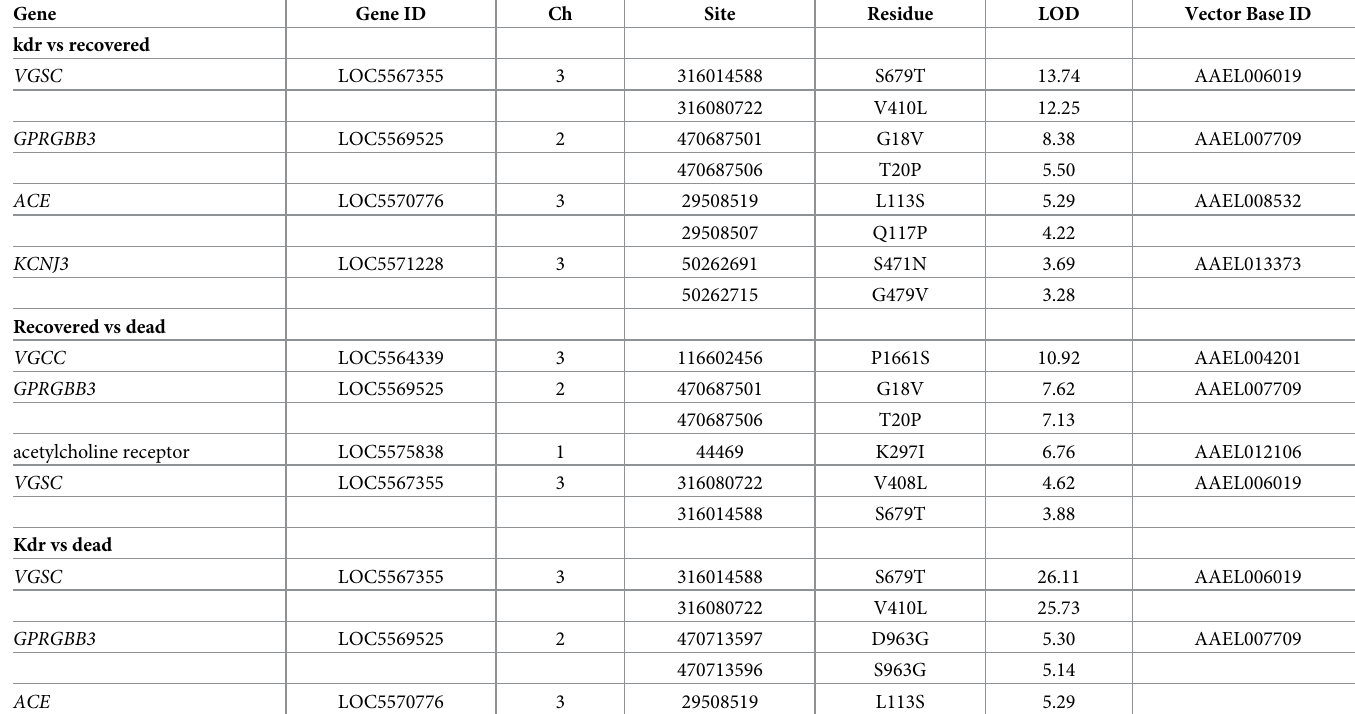
Table 2. Nonsynonymous SNPs at insecticide target sites genes associated with kdr, recovered, or dead Aedes aegypti exposed to permethrin. Gene identification, chromosome (Ch), SNP site and amino acid residue (based in the AaegL5 genome assembly), LOD = -log 10 ( p value vector base gene identification (from